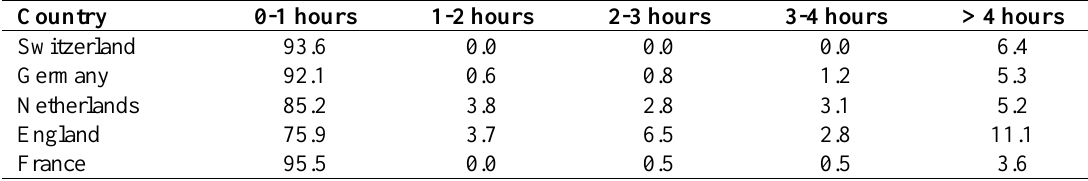
Table 10. Percentage of road connections experiencing congestion (in hours) Country